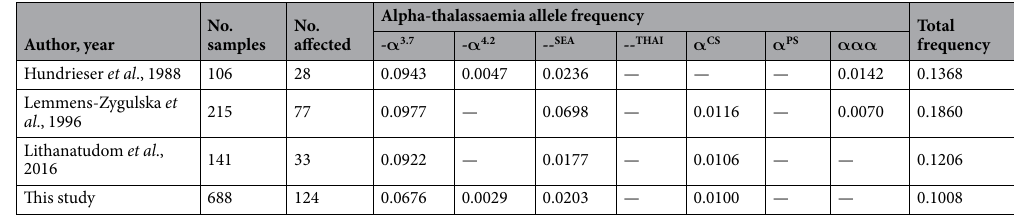
Table 3. Previous reports of α -thalassaemia prevalence in the population residing in northern Thailand.